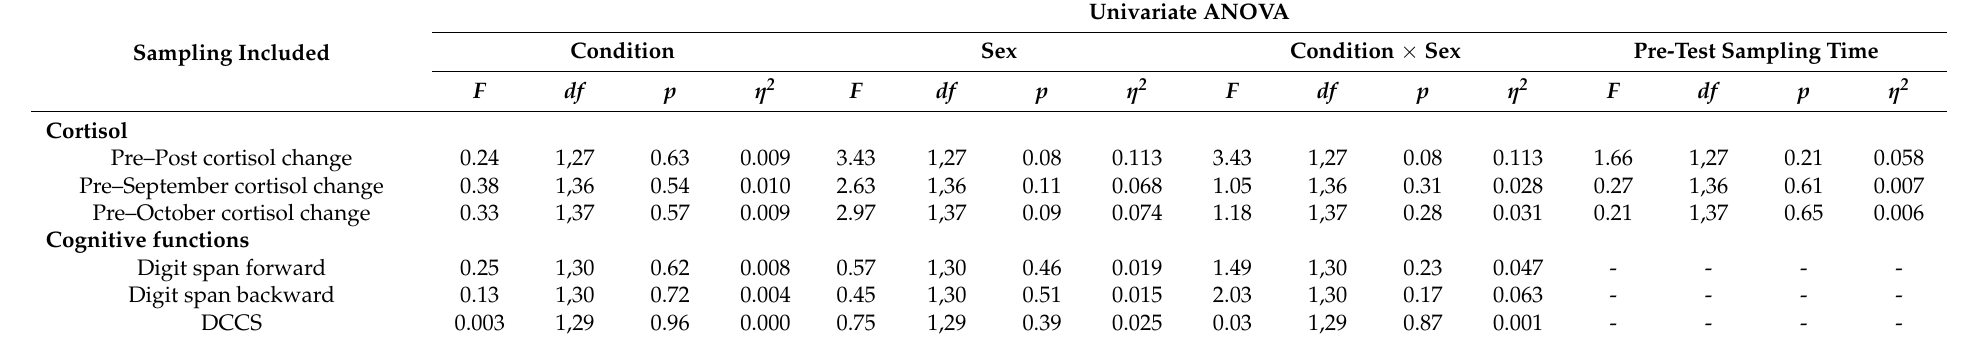
Table A3. Group and sex differences at pre-test.